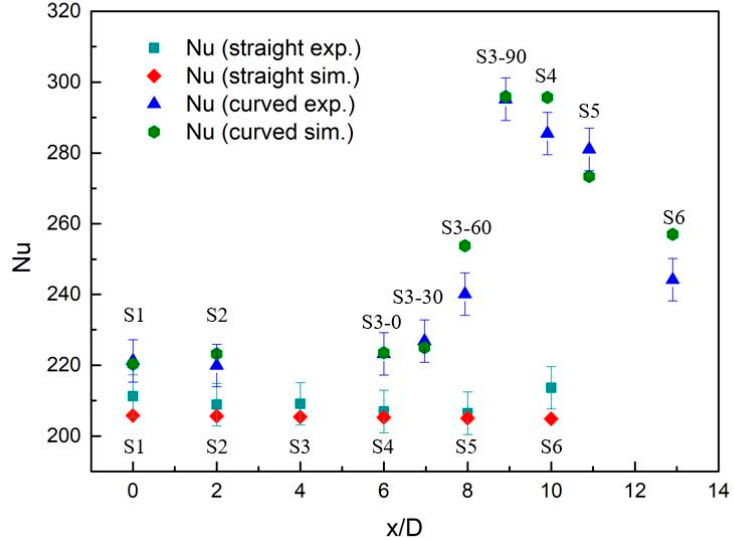
Figure 18. Local Nu comparison between experiment and